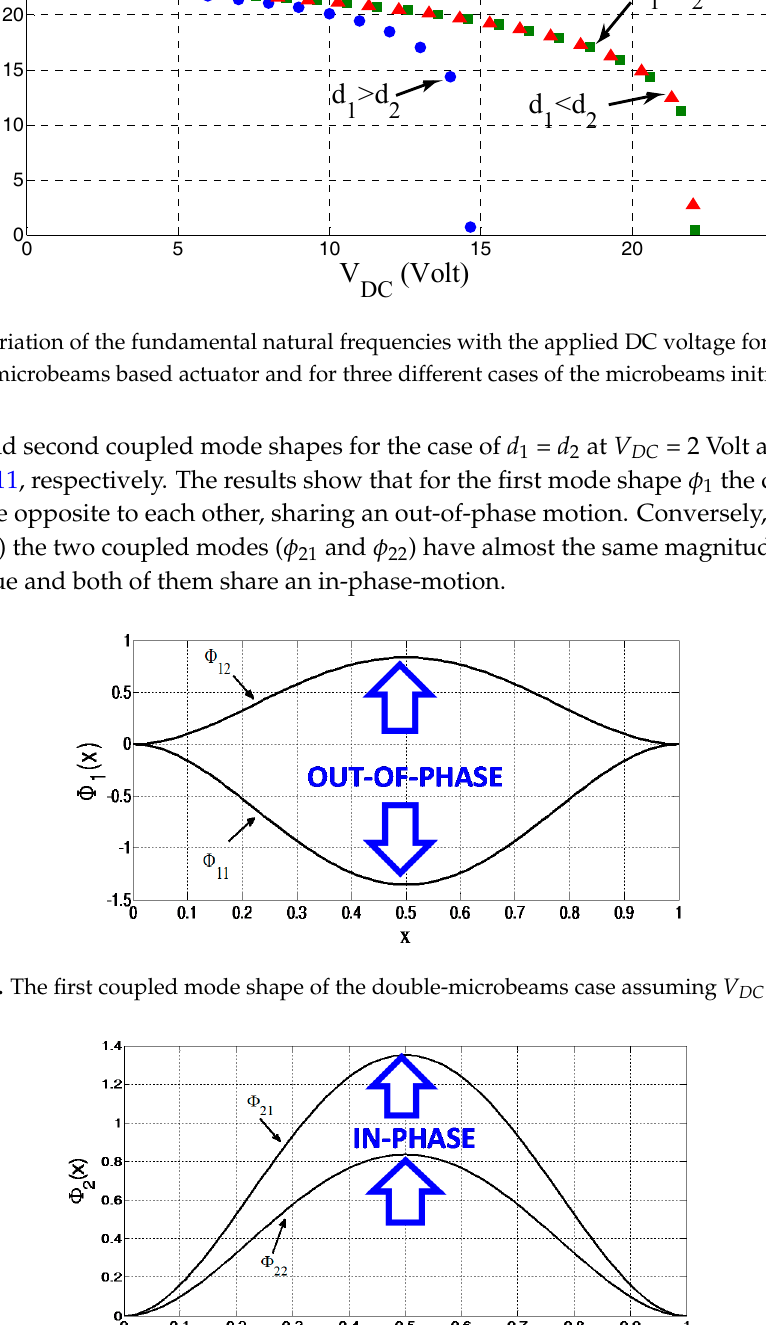
Actuators 2016 , 5 , 22